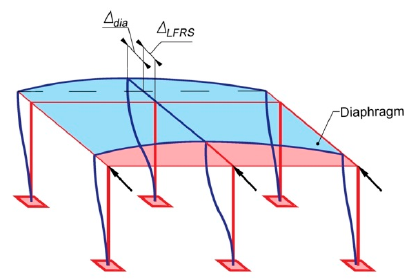
Figure 4. Prescribed diaphragm classification.